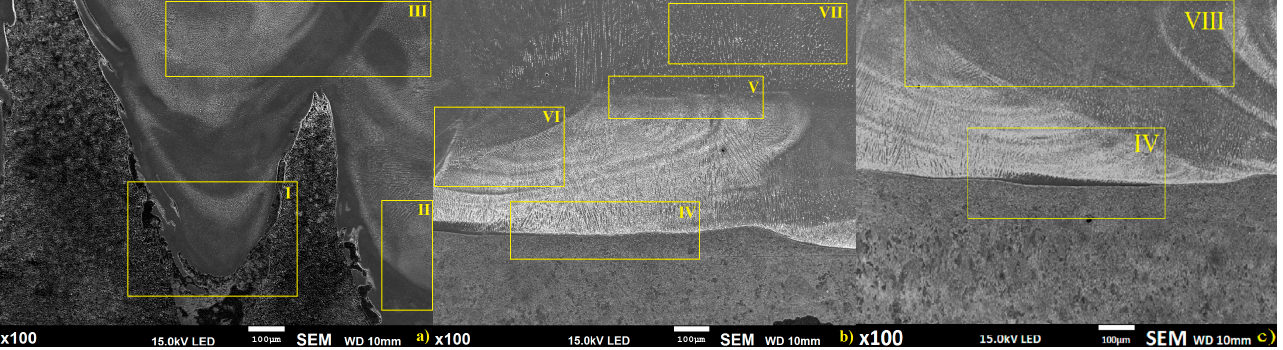
Figure 2. Macroscopic results of the deposited materials using with defined characteristic areas for: ( a ) laser wire deposition method, ( b ) semi-hybrid method, ( c ) laser powder deposition method.